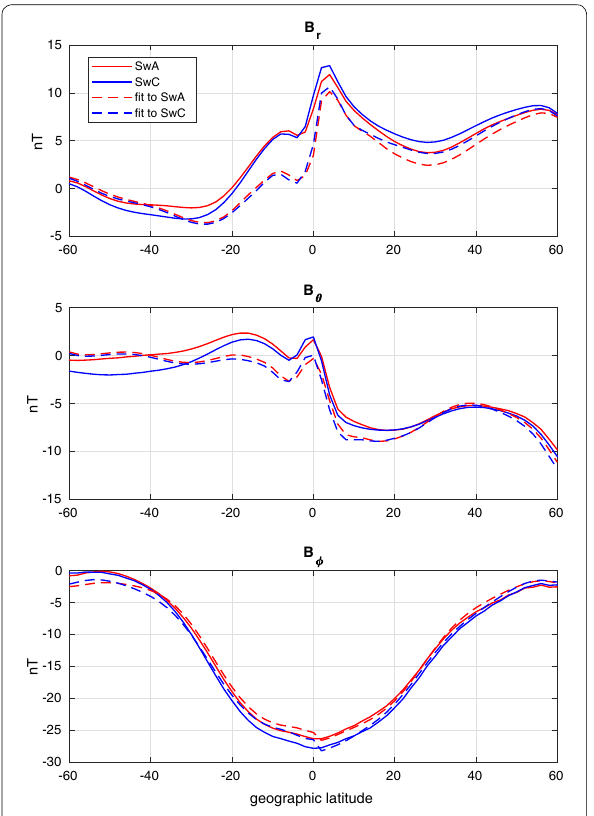
Fig. 2 Test T8. Red and blue solid lines show the magnetic field components measured by Swarm-A/C, respectively, while the dashed lines show the fit from the Swarm/DECS analysis